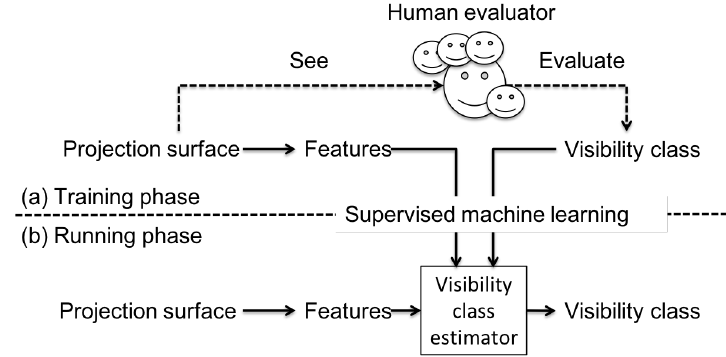
Figure 2. The notion of (a) building (training) an estimator and (b) running